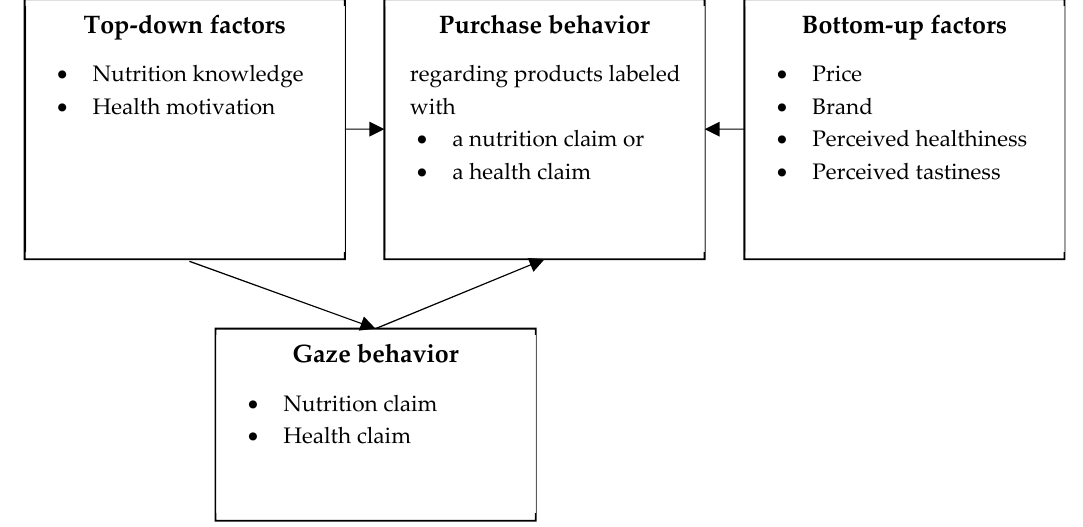
Figure 1. Conceptual model of the study.